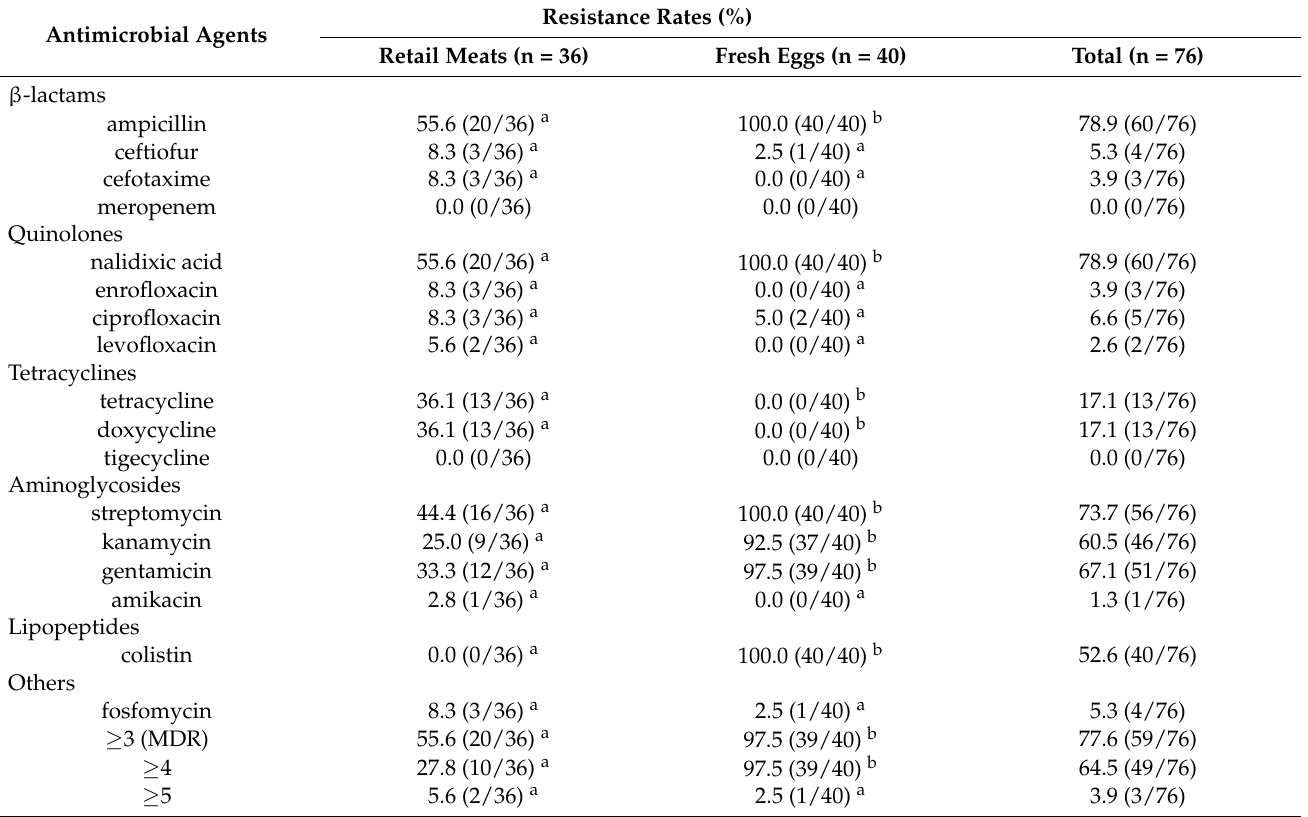
Table 3. Antimicrobial resistance phenotypes of 76 Salmonella isolates from different